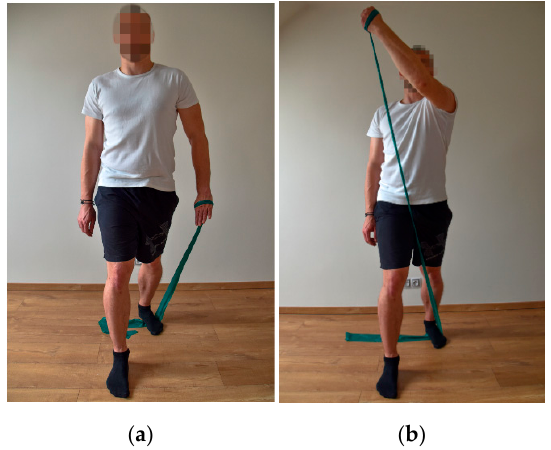
Figure 1. First flexion diagonal—starting position ( a ) and end position ( b ).